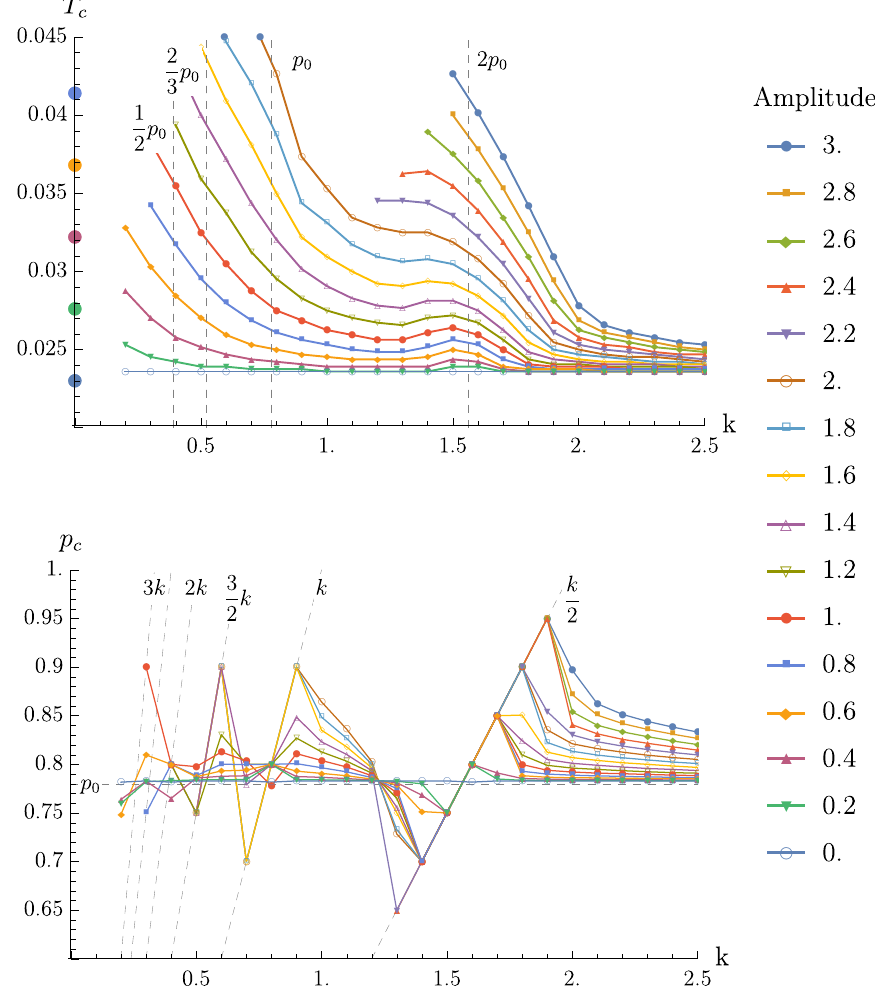
Figure 5 . Critical temperature and preferred wave-vector for the leading striped instability for the backgrounds with di(cid:11)erent lattice wave-vector and amplitude. Our data collection is restricted by the precision issues discussed in the